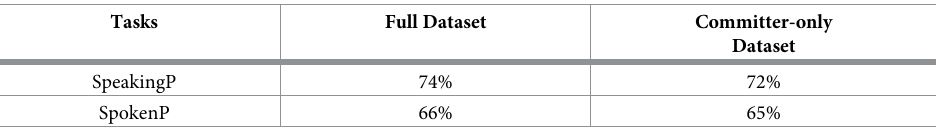
Table 2. AUCs of the Bag-of-Word